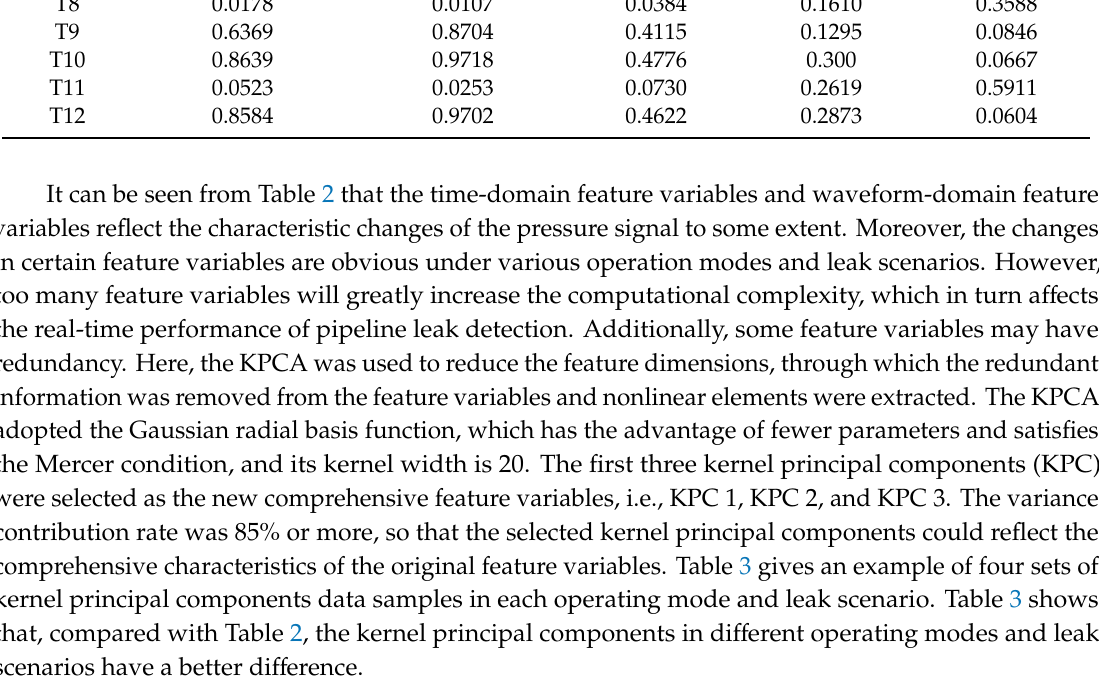
Table 3. Kernel principal components (KPC) data samples in different operating modes and leak scenarios.